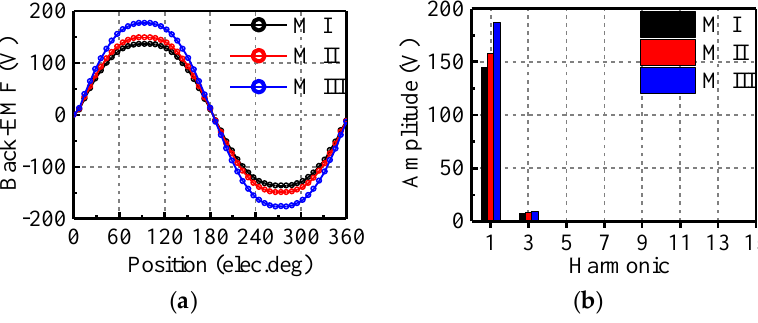
Figure 4. No-load back EMF of the three machines at 600 rpm. ( a ) Waveform. ( b ) Harmonic distributions.